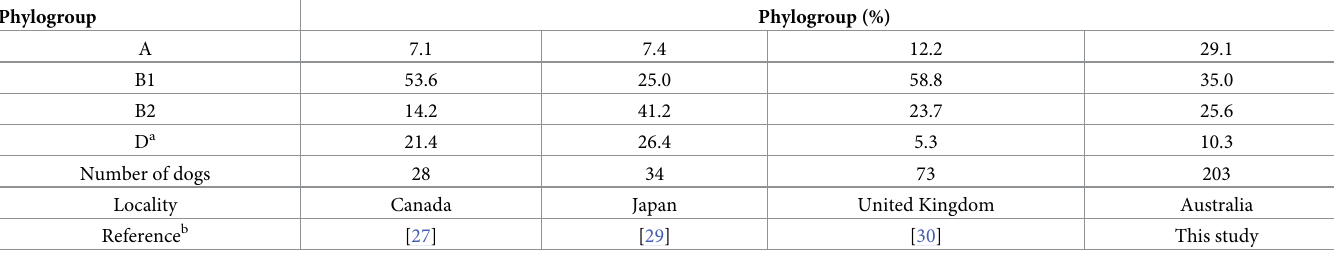
Table 5. Relative abundance of E . coli phylogroups isolated from healthy dogs living in different